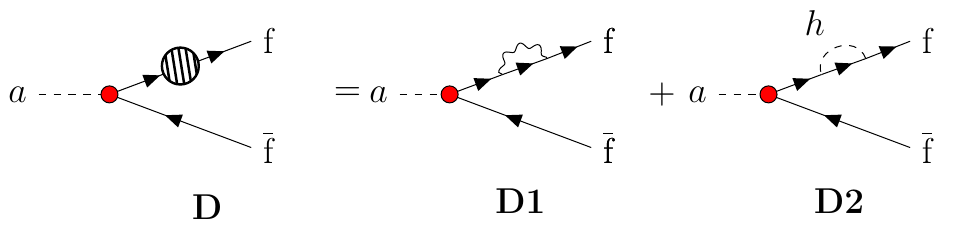
Figure 7 . One-loop diagrams contributing to the correction to the external fermion legs. Diagrams with Goldstone bosons are